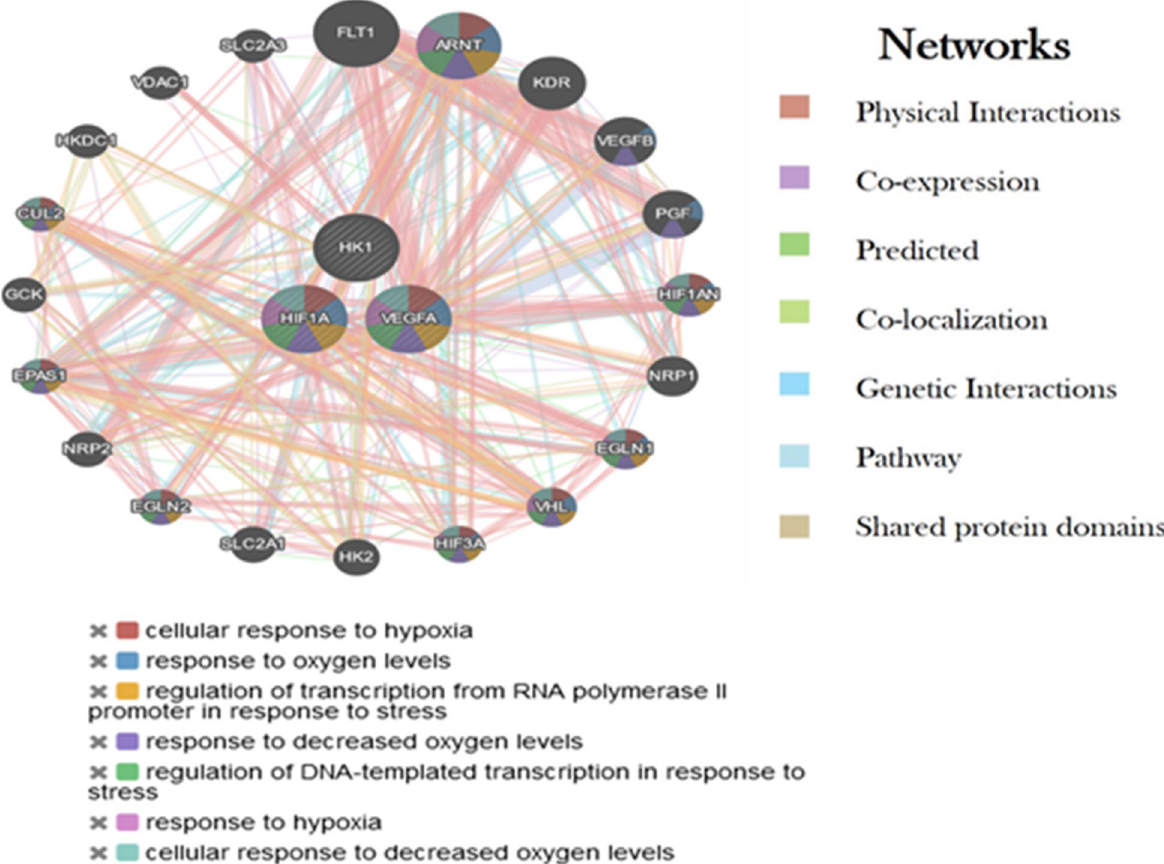
Fig. 9 Interaction of HIF-1α, VEGFA and HK-I genes with other critical genes using various networks. Each colour represents the different type of interaction and their role in various biological